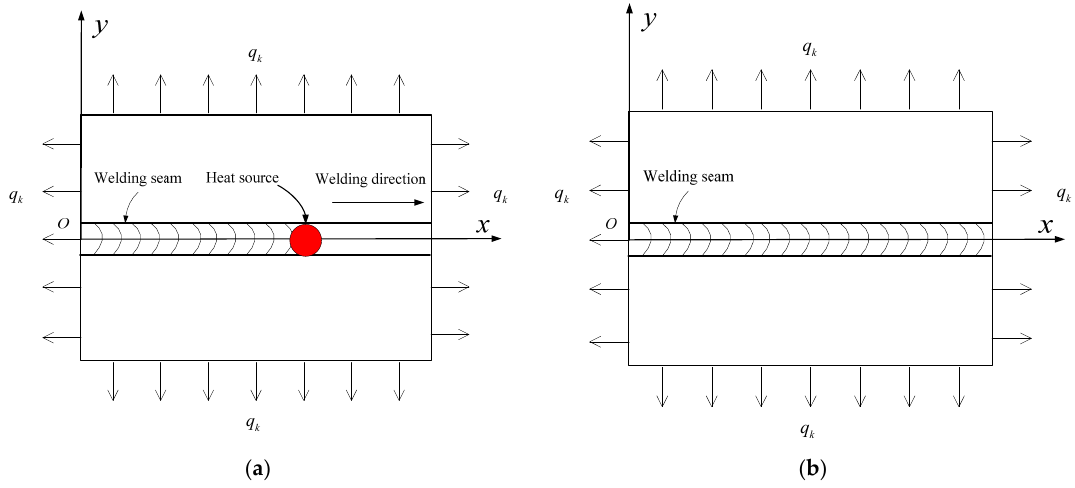
Figure 6. The geometry and welding heating and cooling processes, ( a ) heating process; ( b ) cooling process.